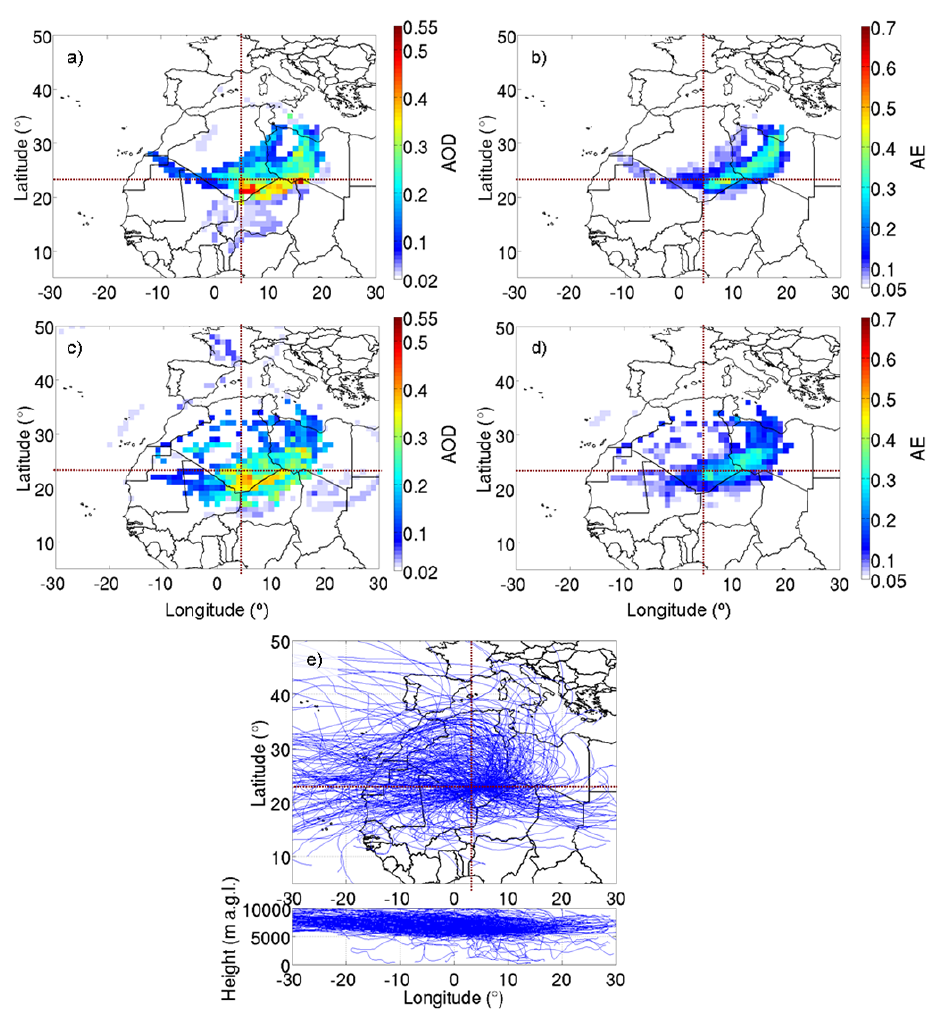
Figure 10. CWT maps for AOD and AE at (a and b) ground level and (c and d) 2600ma.g.l., and (e) HYSPLIT back trajectories ending at 5600ma.g.l., during the wet season (from April to September). Refer to dimensionless white/red scales for colour description of AOD and AE. Tamanrasset is located at the intersection of the four